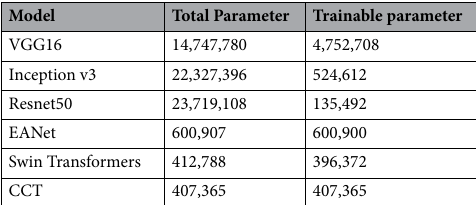
Table 1. No of parameters of different